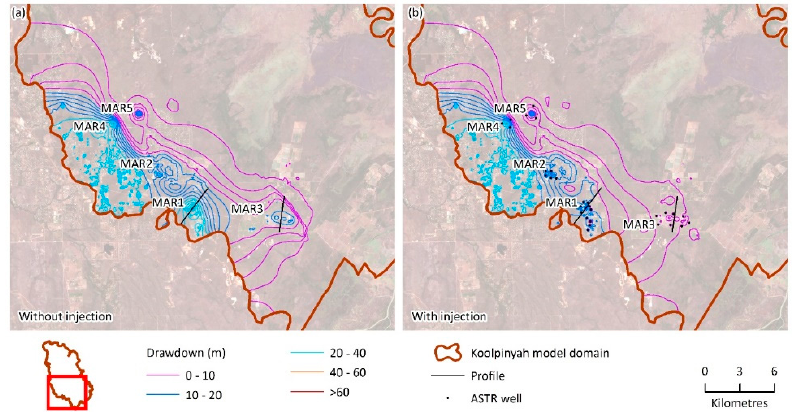
Figure 5. Hydraulic head response to an ASTR (injection well) MAR scheme (SC1b) triggered by declining hydraulic heads. Recharge is typically triggered between August and December. ( a ) The base case without MAR and ( b ) with the effect with MAR.